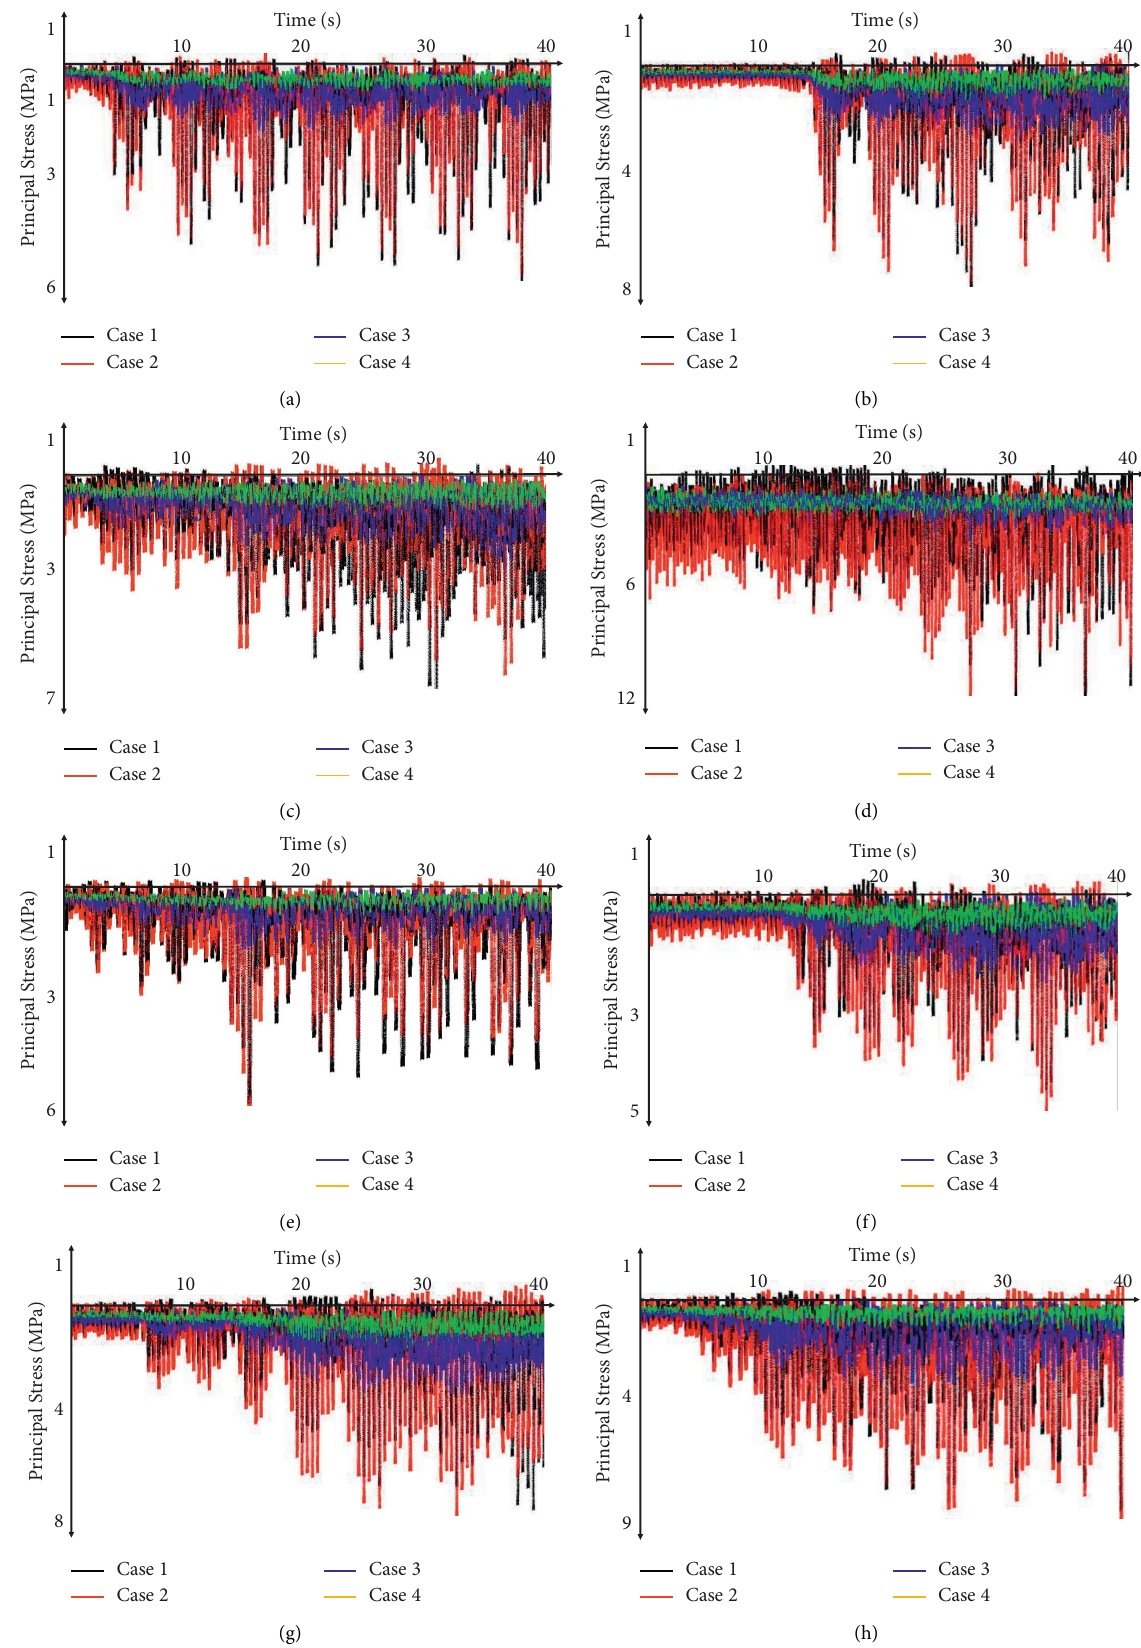
Figure 6: Earthquake PS results of Ermenek arch dam for EQ1–EQ8 earthquakes: (a) EQ1, (b) EQ2, (c) EQ3, (d) EQ4, (e) EQ5, (f) EQ6, (g) EQ7, and (h)